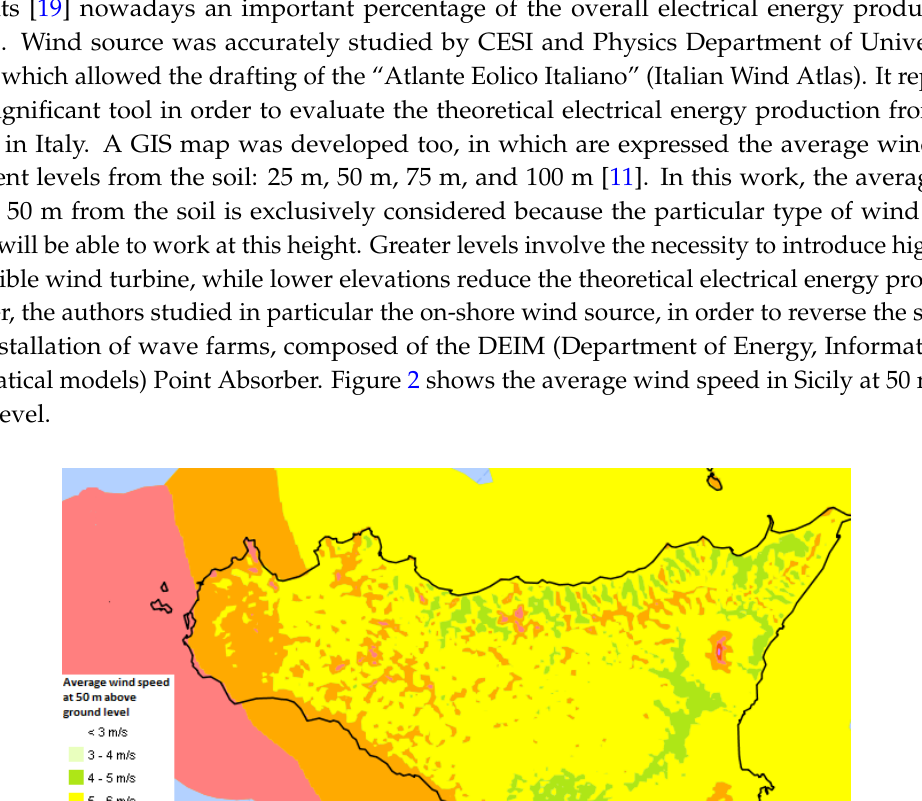
Figure 3. Energy production in Sicily at 50 m above ground level [21].